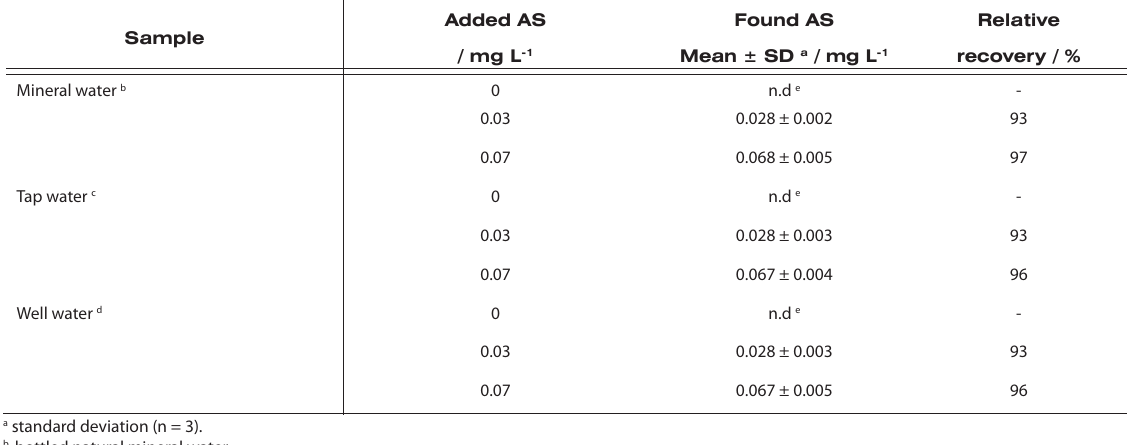
Table 2. Comparison of DLLME/FO-LADS with other extraction methods coupled to spectrophotometry for determination of AS in water